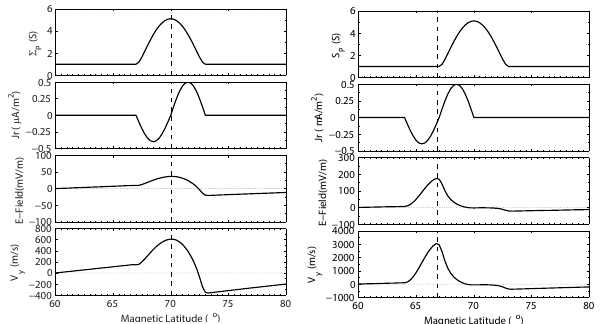
Figure 9. Numerical simulation of high-latitude plasma dynamics. From top to bottom frames show the Pedersen conductivity (sine wave), FACs (sine wave) and the derived electric field (positive de- notes poleward) and azimuthal velocity (positive denotes sunward) from Eq.